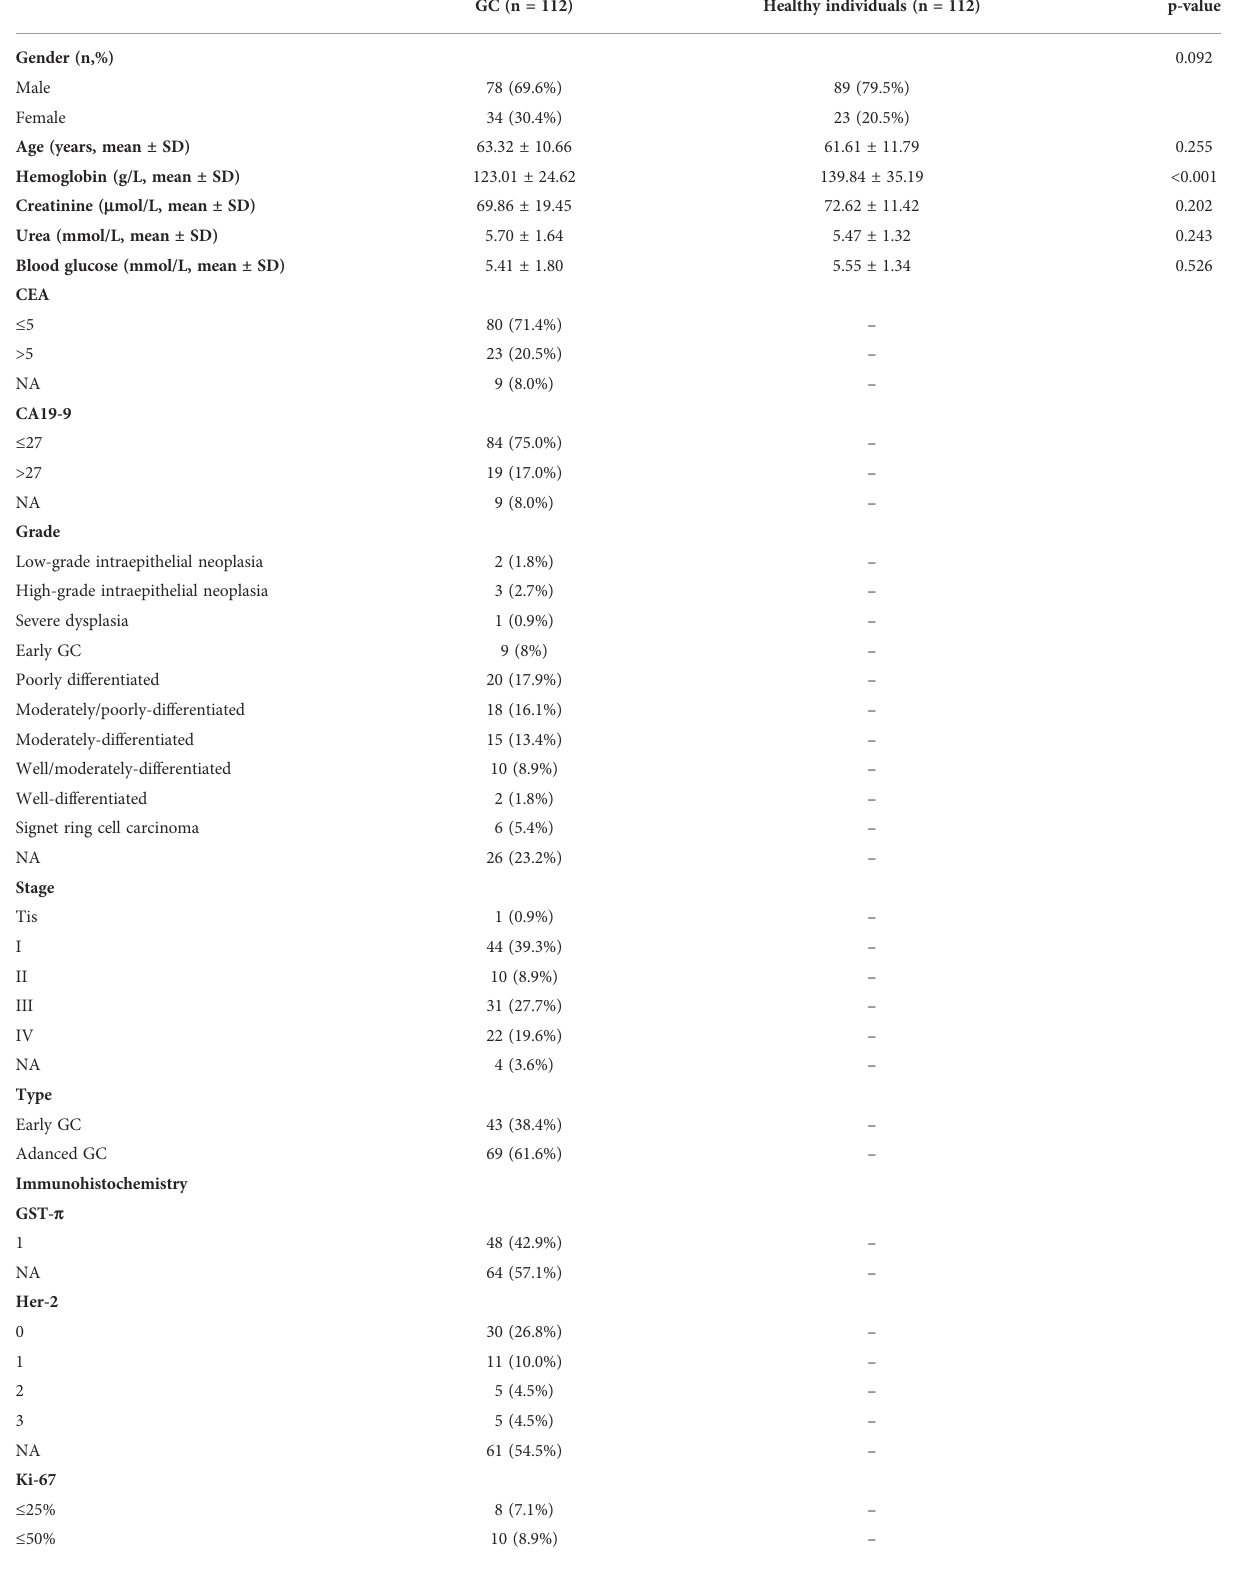
Table 1. Clinical characteristics of the GC patients used for untargeted